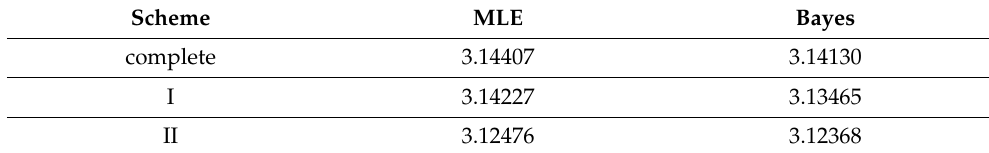
Table 10. Estimated τ .